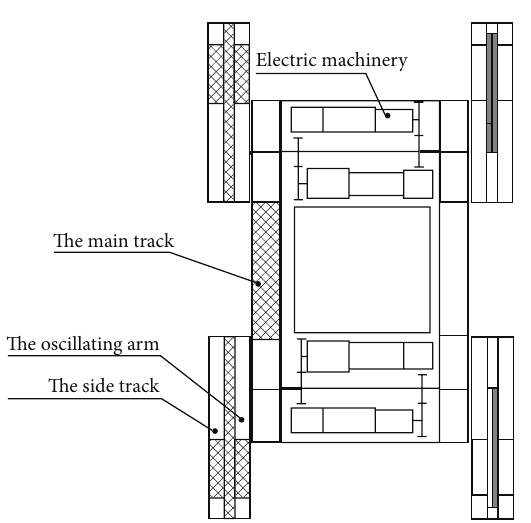
Figure 6: Structure of the tracked mobile system MROBOT-I.